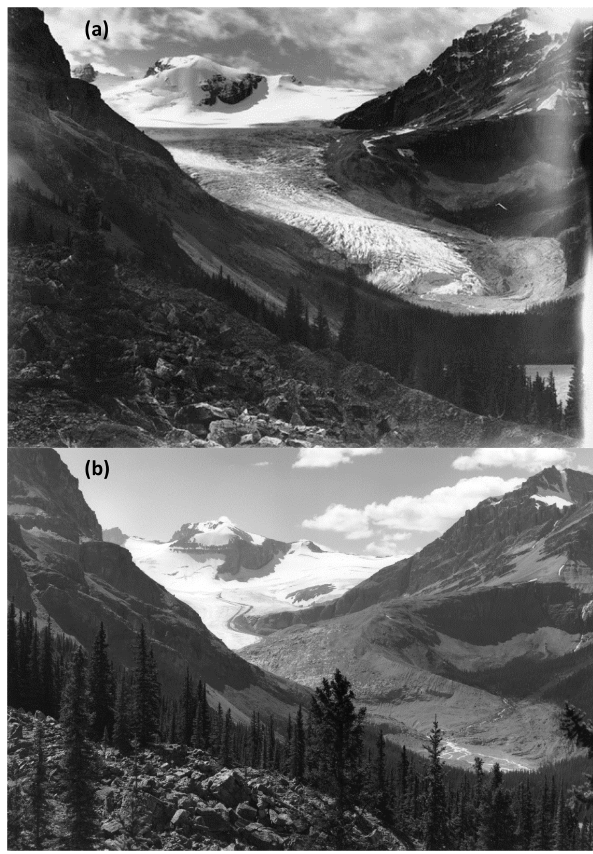
Figure 2. Peyto Glacier in (a) 1902 (V653/NA-1127, Vaux Family, Whyte Museum of the Canadian Rockies, https://Whyte.org, last access: 7 September 2018) and (b) 2002 (courtesy Henry Vaux